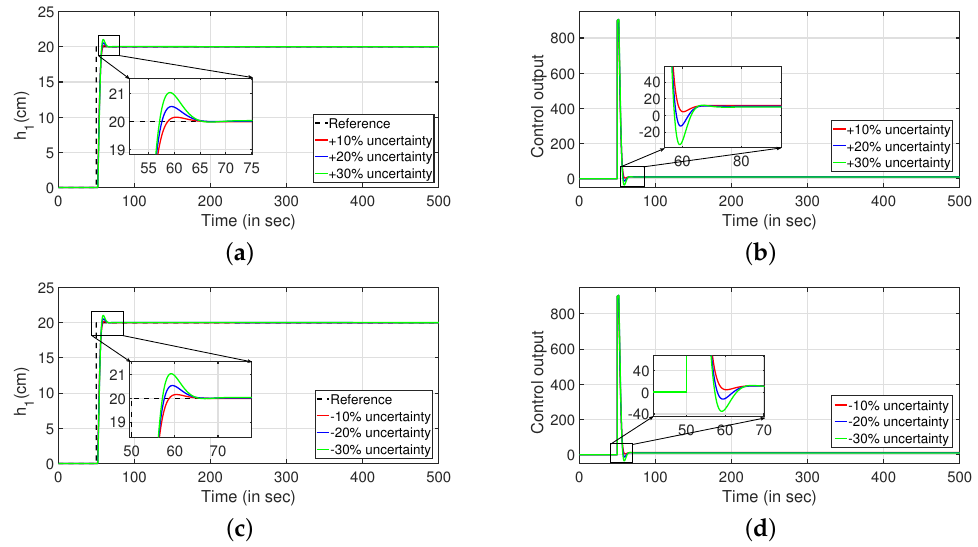
Figure 11. Reference tracking of Equation (37) for ± 10%, ± 20% and ± 30% uncertainties. ( a ) Level Variation in tank 1. ( b ) Control output. ( c ) Level Variation in tank 1. ( d ) Control output.